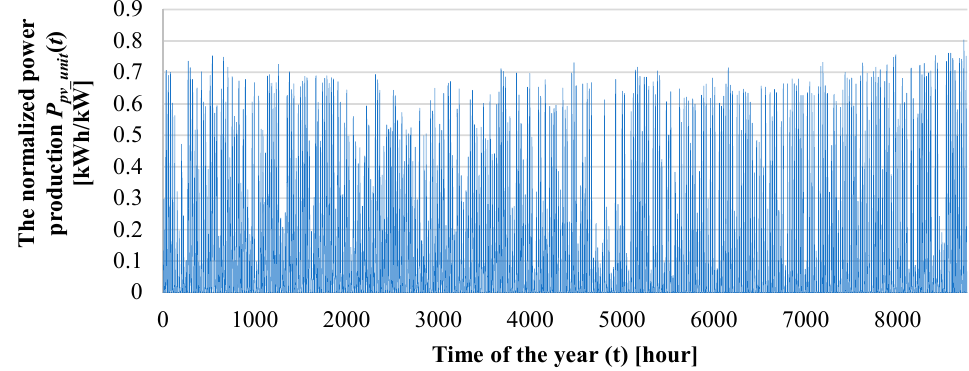
Figure 5. Residential power demand.